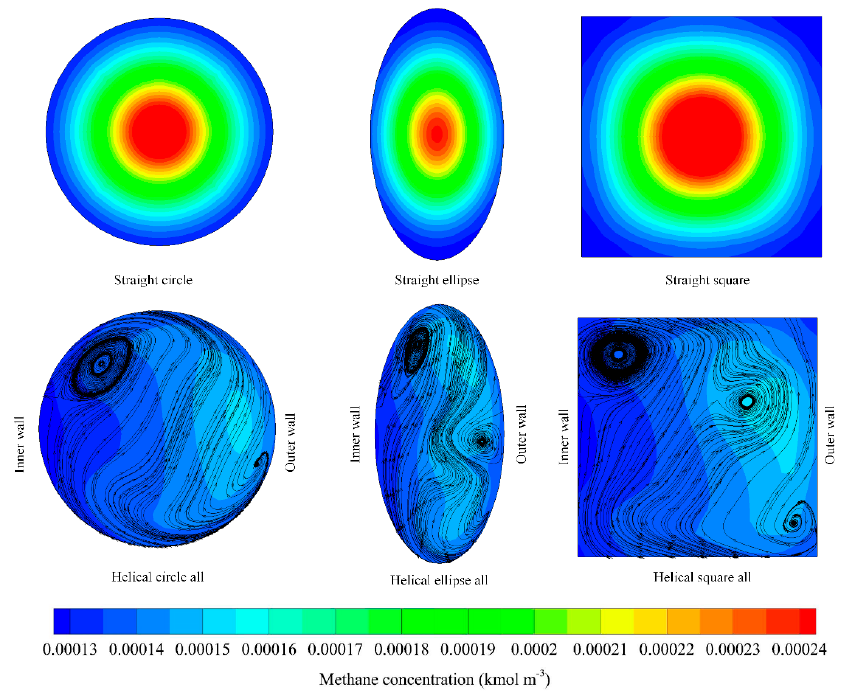
Figure 6. Methane concentration (kmol m − 3 ) and masslines in ( a ) straight circle, ( b ) straight ellipse, ( c ) straight square, ( d ) helical circle, ( e ) helical ellipse, and ( f ) helical square tubes at L = 31 mm and Reynolds number of